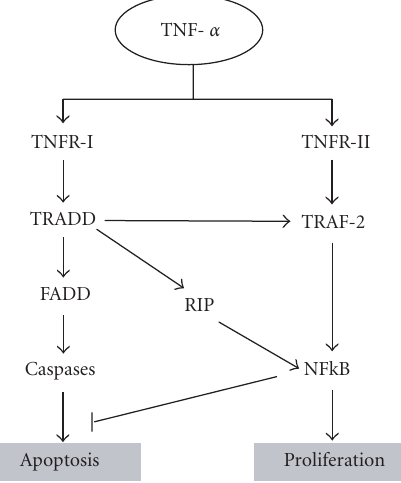
Figure 1: An overview of the TNF- α signaling pathway leading to apoptosis or proliferation of the